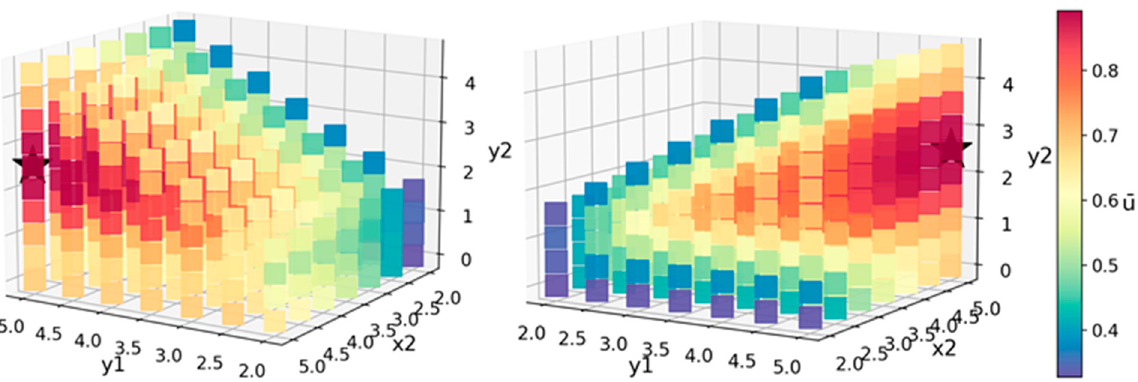
Figure 7. The three-dimensional scatter diagram of average inflow velocity. The left and right pictures are two different side views of the scatter. The three axes are the three distance parameters ( y 1, x 2, y 2). The color bar represents the average inflow velocity. The black star represents the maximum average inflow velocity (its coordinates are y 1 = 5, x 2 = 5, y 2 = 2.5).